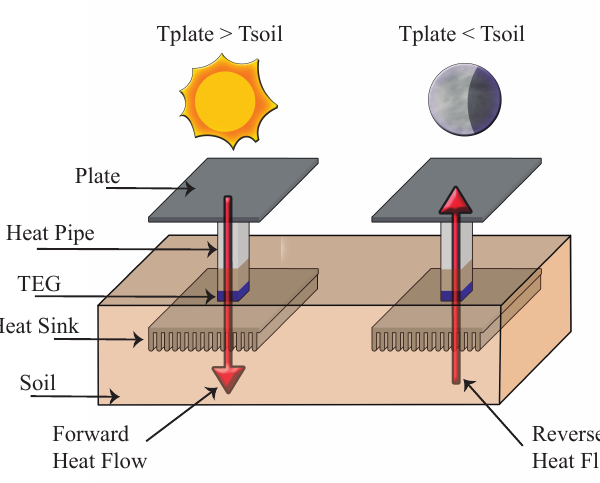
Figure 1. Heat flow in an energy harvesting system flat panel system with buried heat sink: when the temperature of the flat panel is higher than the temperature in the soil, the heat flows from the flat panel to the soil; when the temperature of the soil is higher than the temperature in the flat panel, the heat flows from the soil to the flat